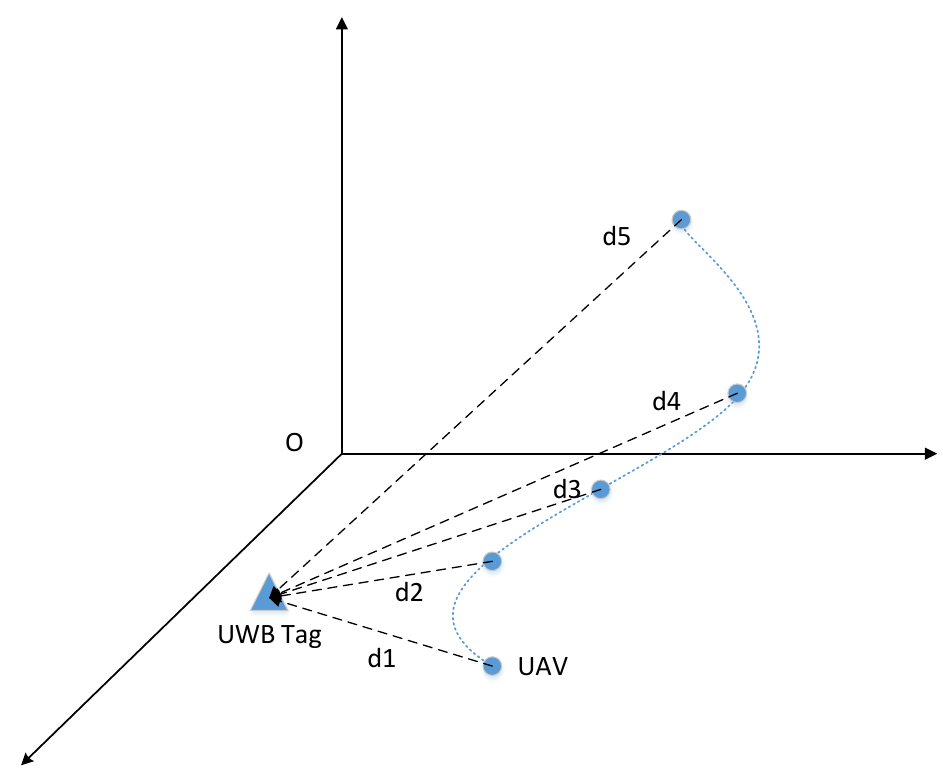
Figure 2. RO-SLAM schematic diagram. The blue dotted line represents the flight path of the UAV over a period of time, the blue dots represent the position of the UAV at different times, and the blue triangle is the node to be